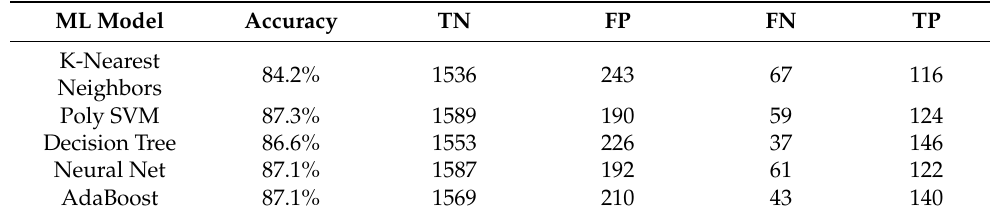
Table 3. Accuracy and elements of the confusion matrix after checking the ML model on the testing